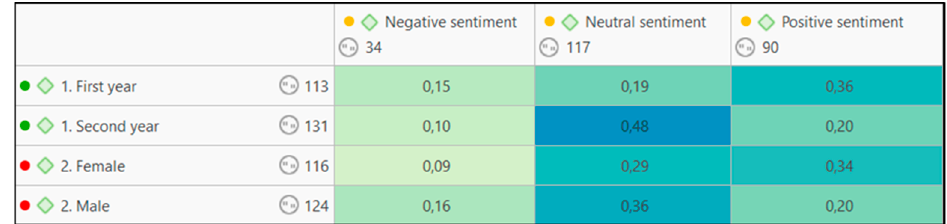
Table 1. Table of co-occurrence between emerging categories.